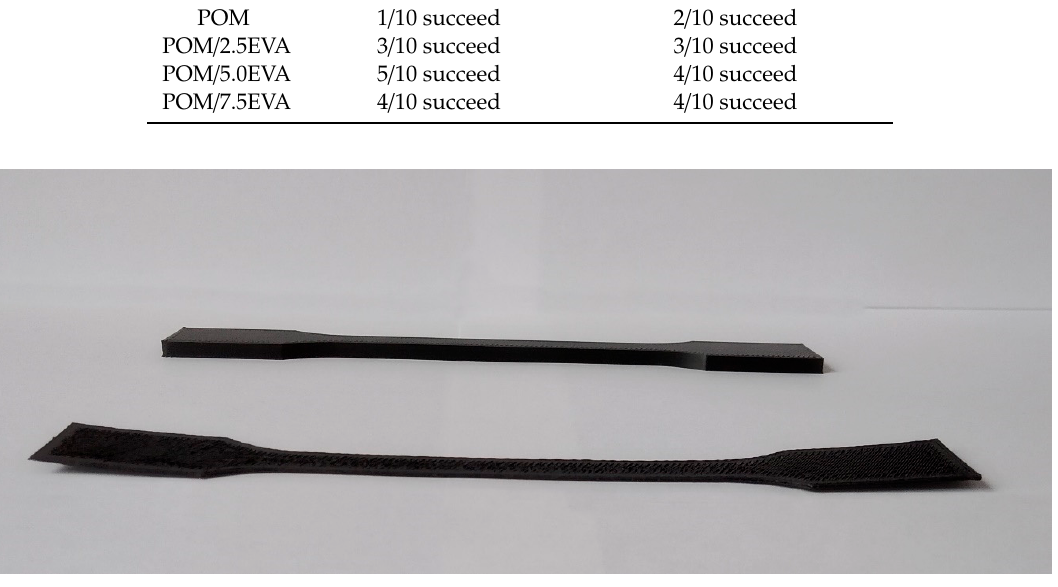
Figure 7. Warping of neat POM at the beginning of the 3D printing compared to the completed specimen. Table 10. Results of 3D printing